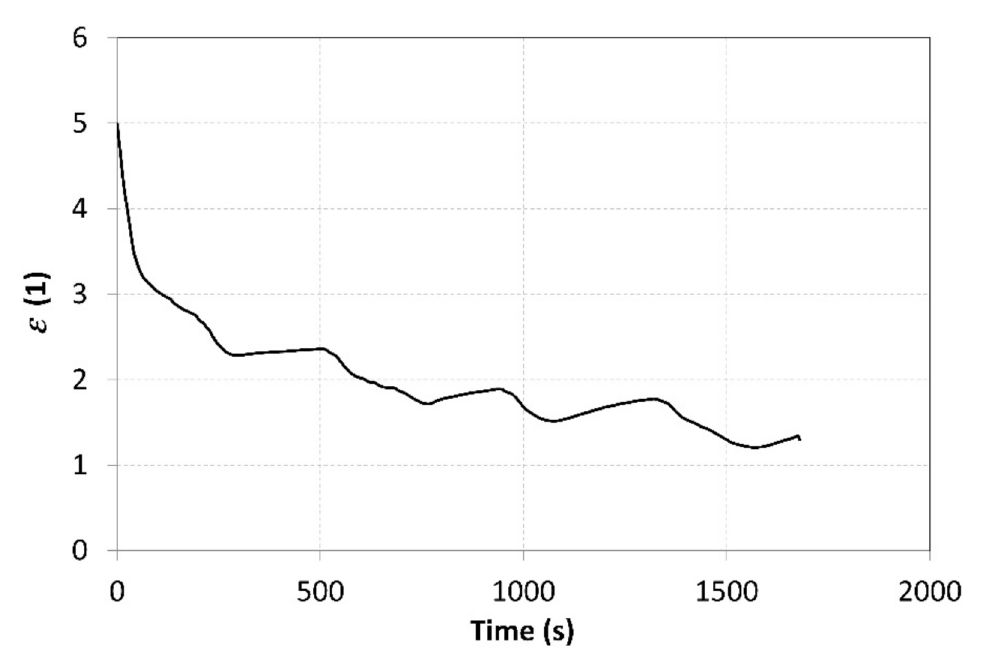
Figure 13. Curve of the compression ratio throughout the compressor